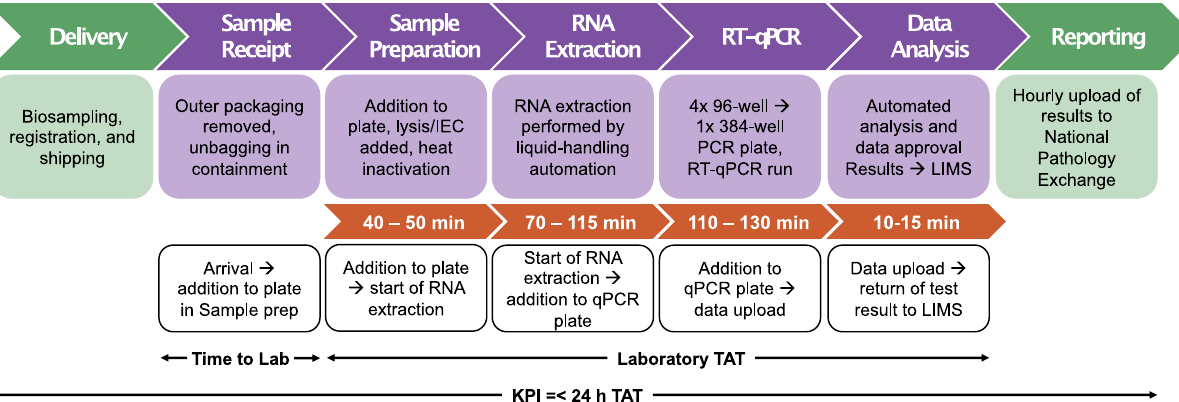
Figure 1. Standard laboratory process showing the journey of a sample from bio-sampling to result. Purified SARS Cov-2 RNA from clinical swab samples is detected by RT-qPCR targeting the ORF1ab gene. Flow diagram at the top describes each step; the internal laboratory procedure shown in purple, and the external processes in green. The time recorded for each step to occur is highlighted in orange. Definition of the Laboratory Information Management System (LIMS) timestamps described in this manuscript are outlined in the white